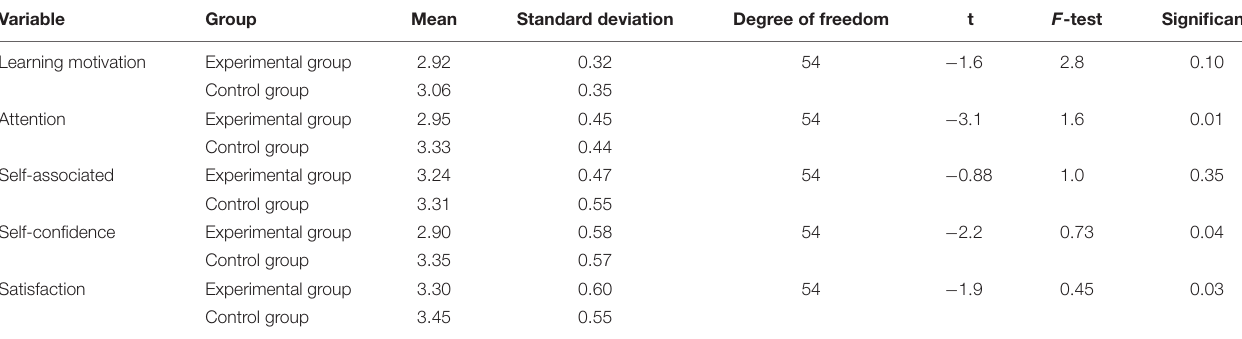
TABLE 6 | Homogeneity test of pre-test of action skill grouping and free grouping in basketball skill performance. Variable Group Mean